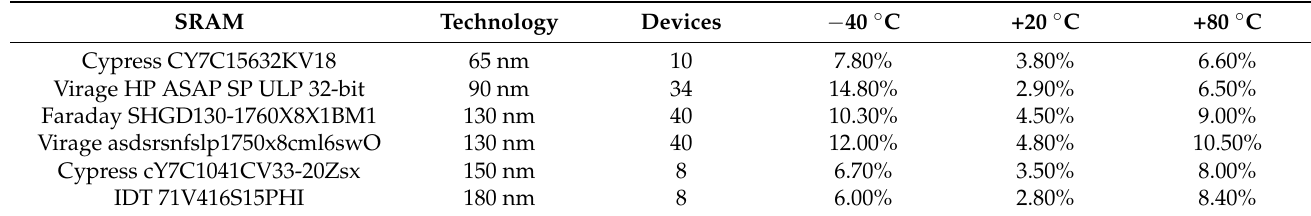
Table 1. Instability rate of SRAM devices for different